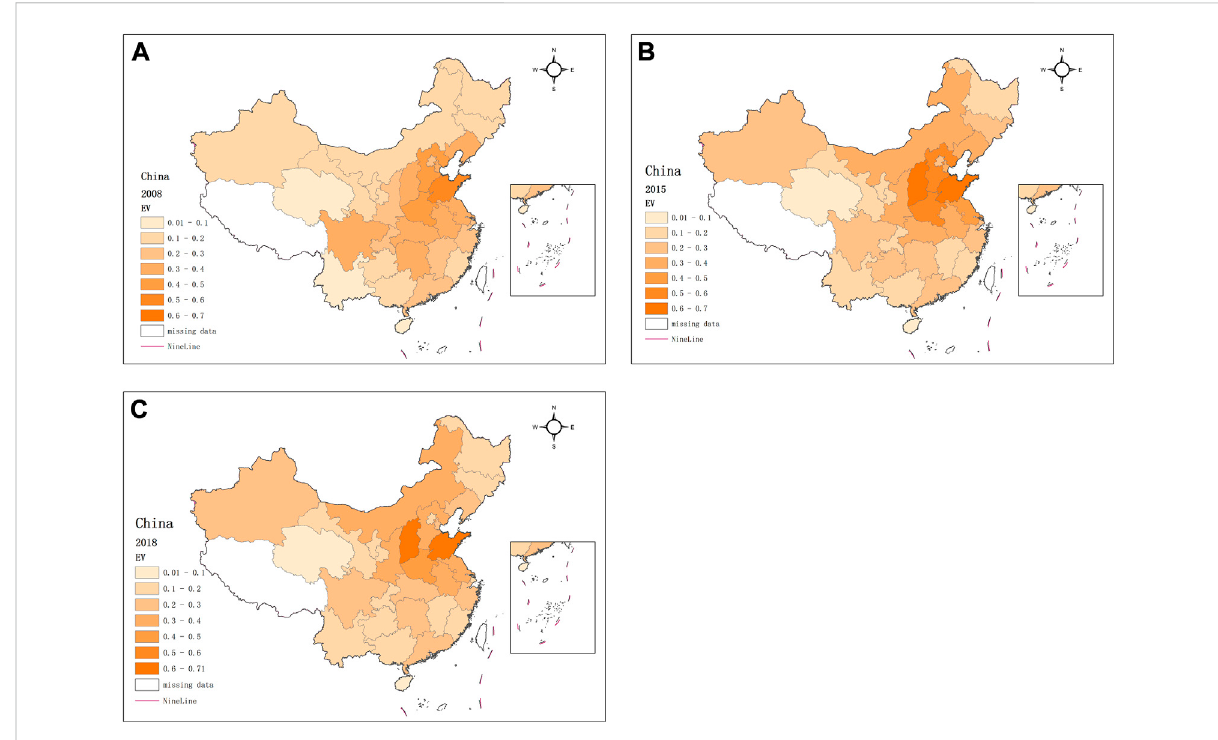
FIGURE 4 Spatial and temporal evolution of environmental